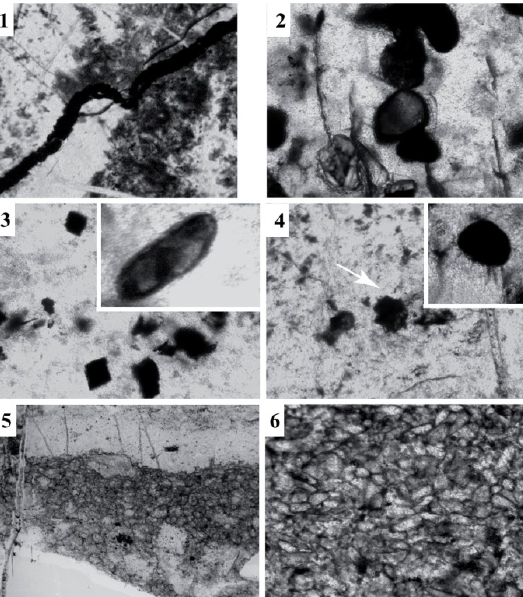
Fig. 2. Obruchevella, A, B and D–G are photomicrographs from thin-sections; C is a scanning electron micrograph of an acid- extracted specimen. In this and subsequent figure legends YPM numbers are given, in addition to rock sample/thin-section identifications and, where appropriate, England Finder coordinates for all illustrated sedimentary structures, microfossils and populations. A, O. delicata, YPM 536750, M602 176.0 B,